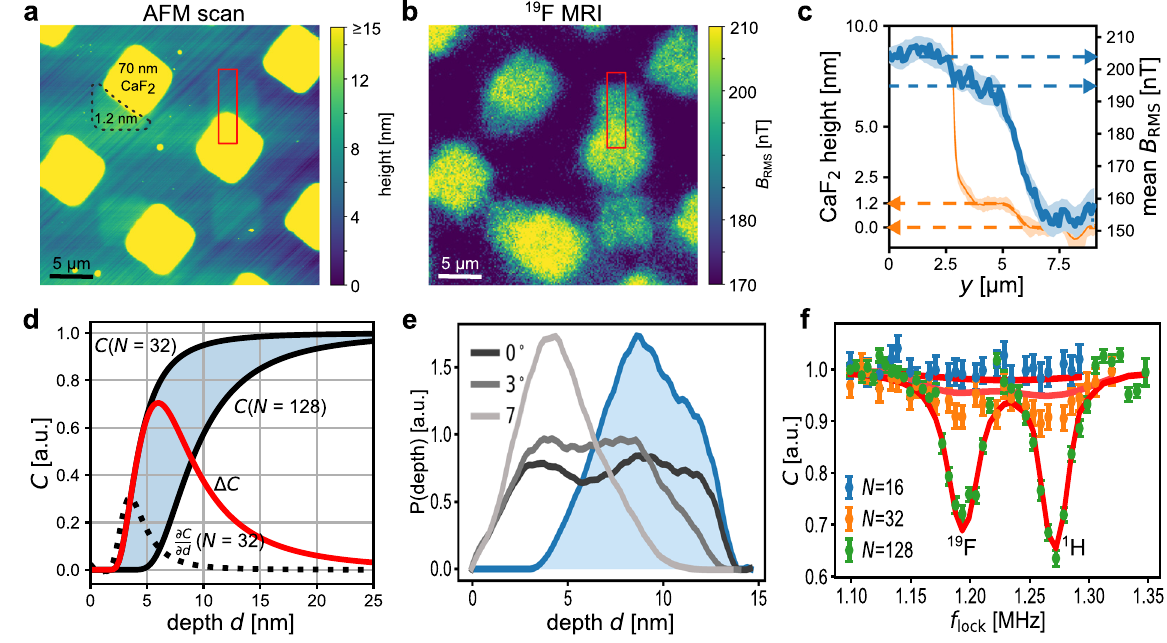
Figure 2. Nuclear magnetic resonance imaging. The diamond surface was patterned with CaF 2 islands. ( a ) AFM scan of the diamond surface. ( b ) Approximate effective magnetic field amplitude B rms measured with XY16-256. ( c ) Profiles of the surface (orange, AFM data) and 19 F B rms (blue, magnetometry data) along a transition from 70 nm CaF 2 to 1.2 nm CaF 2 to the bare diamond at y = 3 and 5.5 μ m, respectively. ( d ) Calculated on-resonance lock-in contrast C ( d ) to reconstruct the distribution of NV depths in the ensemble. The coherence loss due to the nuclear phase noise depends on NV depth and the duration of the lock-in (given by N ). Single measurements have a limited dynamic range (derivative ∂ C / ∂ d , dotted black line), while the integral over pairwise differences (shaded blue) contains information about intermediate depths (difference in contribution to ensemble contrast, solid red line). ( e ) Recovered distribution of NV depths (blue, filled), based on CTRIM simulations of N + implantation for 2.5 keV at angles 0°, 3°, and 7° against the surface normal (grey to black lines, respectively), as well as a depletion zone. ( f ) Ensemble averaged data for NVs below 70 nm CaF 2 and fit using the recovered distribution of